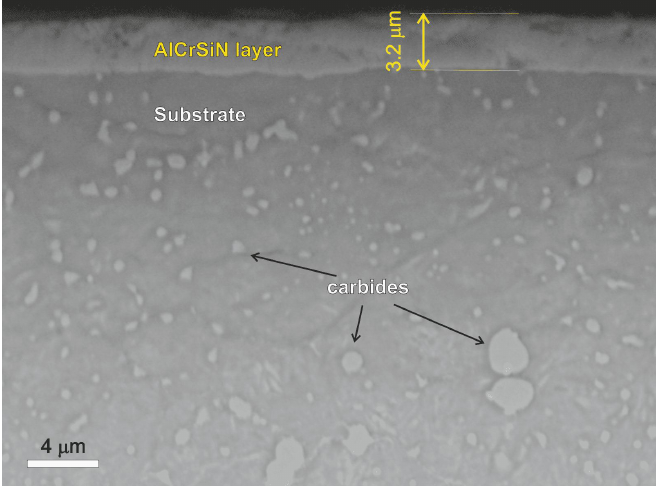
Figure 2. Scanning electron microscopy (SEM) image of K340/AlCrSiN sample. Table 5. Average contents of elements in the analyzed AlCrSiN layer. Concentration Symbol Atomic, at. % SD, at. % Weight, wt. % SD, wt.